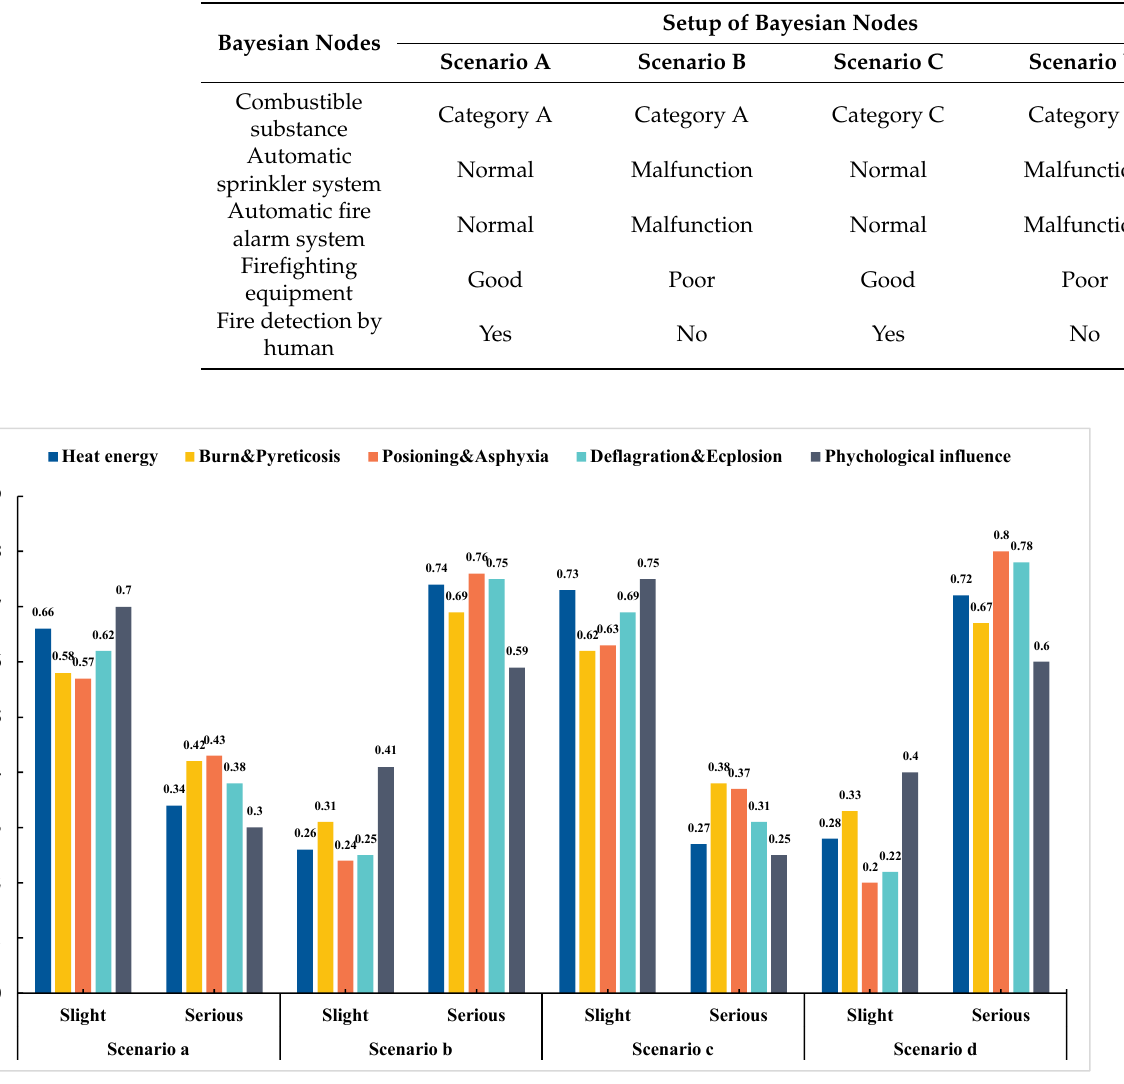
Figure 11. Probabilities before and after Scenario 2 occurrence.